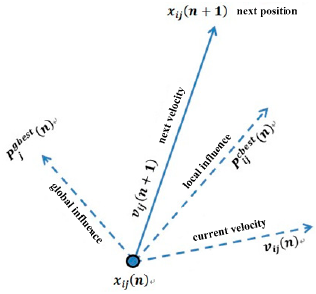
Figure 1. Principle of particle flying.